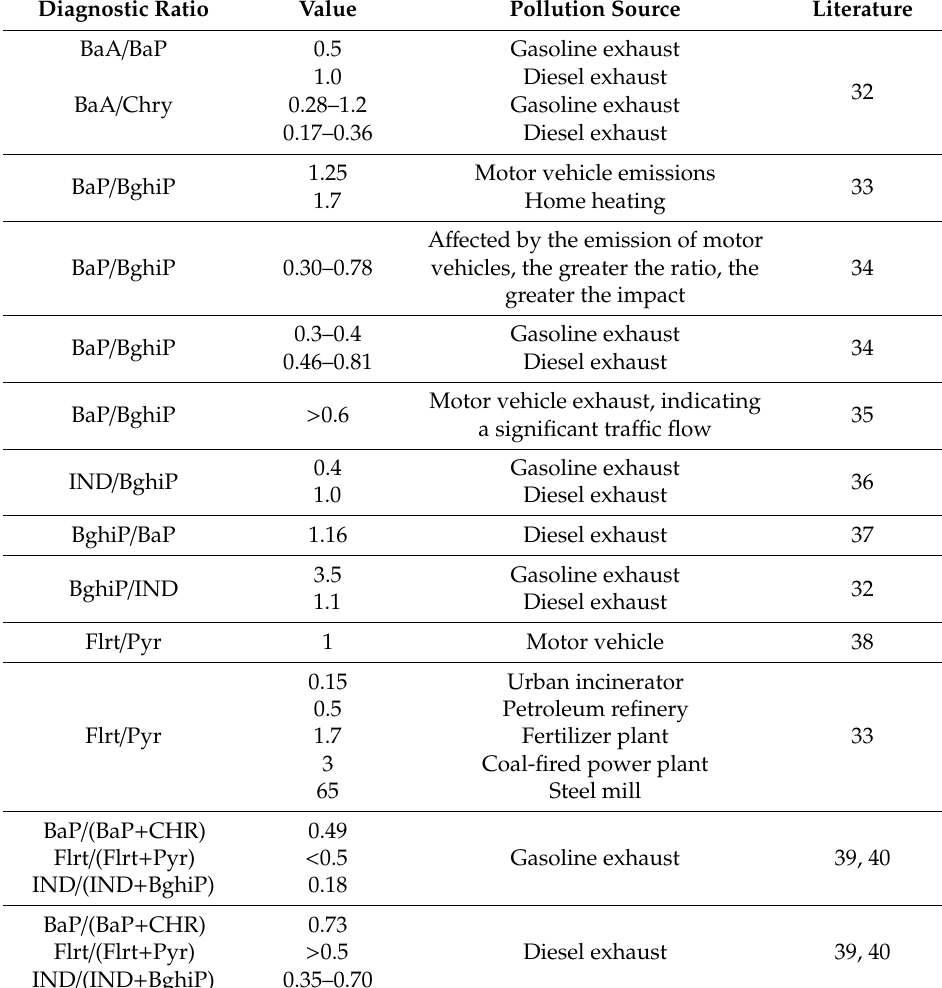
Table 4. Some PAHs diagnostic ratios used for tra ffi c and industrial source